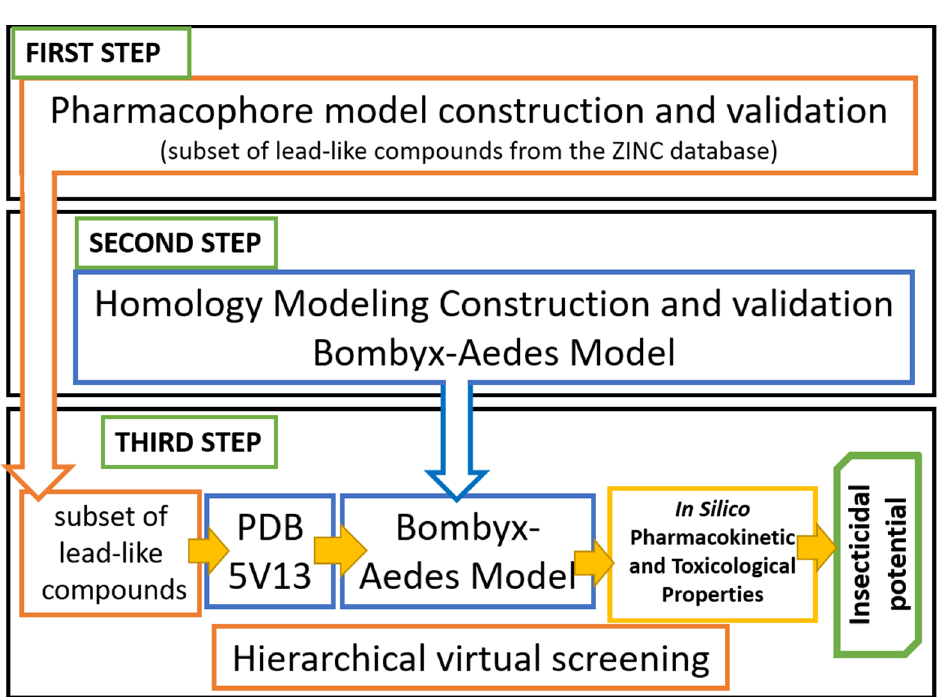
Table 1. Internal statistical parameters for pharmacophore models provided by GALAHAD™.